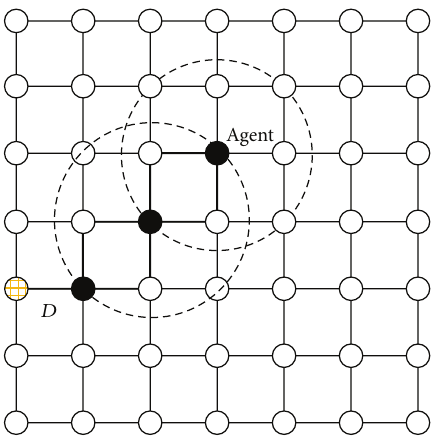
Figure 2: DDTA agent control